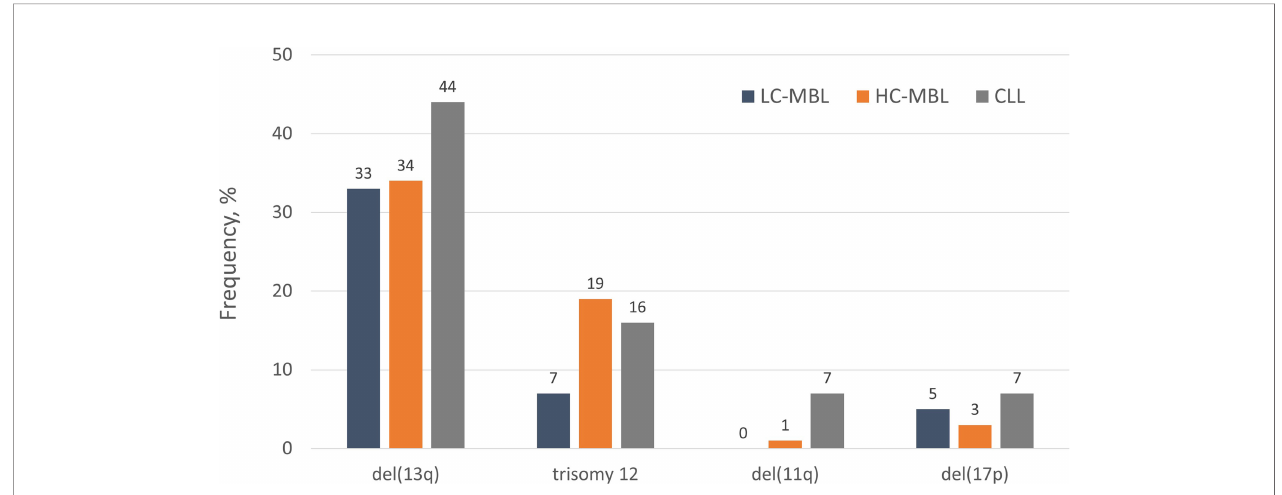
FIGURE 1 | The distribution of “ CLL-speci fi c ” cytogenetic aberrations in LC-MBL, HC-MBL and indolent CLL. Data was extracted from the studies by Rossi et al (17), Fazi et al. (2) and Henriques et al.